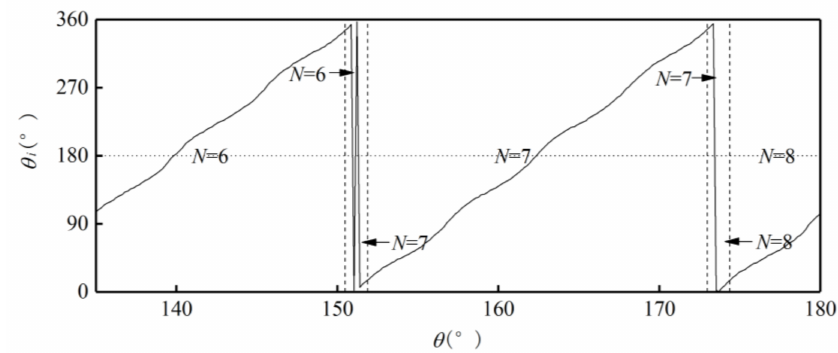
Figure 10. Relationship between single-cycle angle and pole